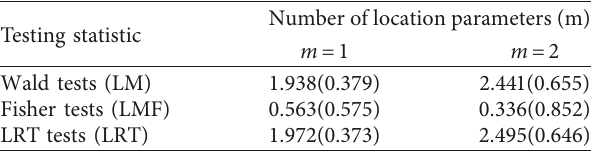
Table 8: No-remaining nonlinear test